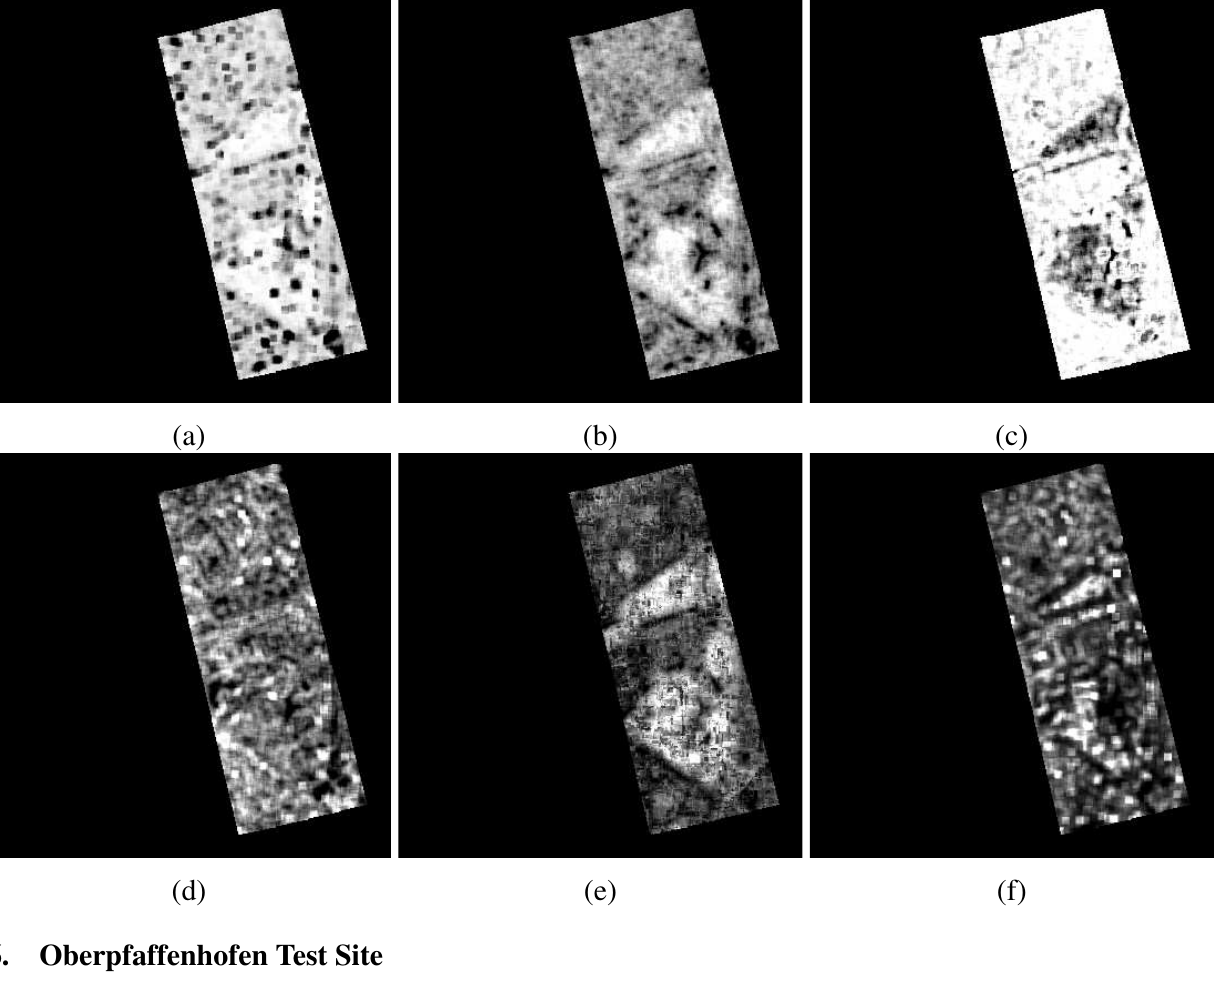
Figure 6. Similarity images of the push-broom and XS data - case b : (a) distance to in- dependence; (b) mutual information; (c) cluster reward algorithm; (d) Woods criterion; (e) robust Woods criterion; (f) correlation